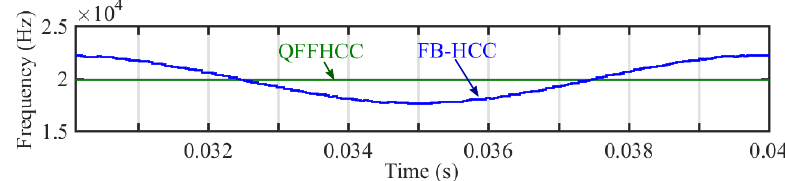
Figure 18. Comparison of switching frequencies in the case of FB-HCC and the QFFHCC.